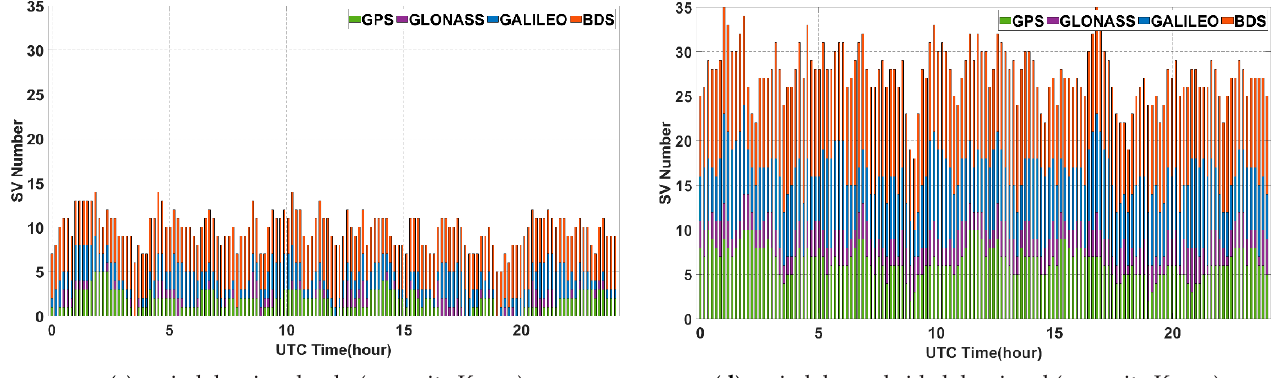
Figure 6. GNSS satellite visibility for 24 h in geostationary orbit.